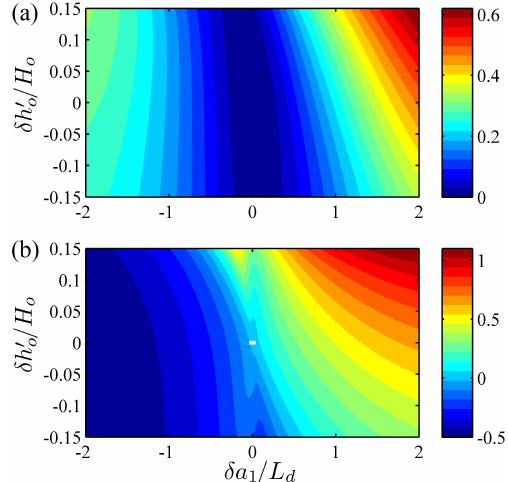
Figure 3. (a) The non-dimensional kinetic separation-squared when a 1 /L d = 4 and h (cid:48) o /H o = 0 . 8. (b) Fractional error of linearized ki- netic separation-squared from (a) . The white dot at the centre marks the